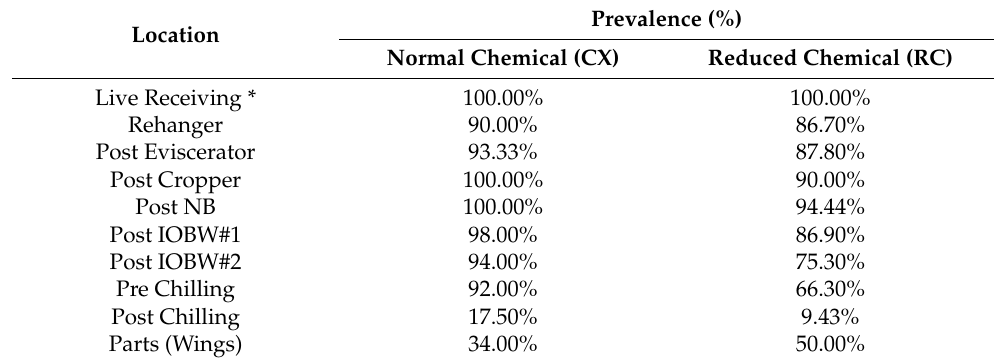
Table 7. Prevalence of Campylobacter spp. at each Sampling Location for each Treatment: Normal Chemical (CX) and Reduced Chemical